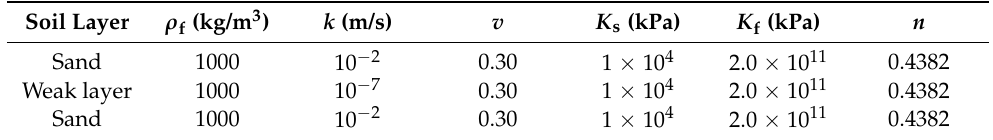
Table 3. Pore fluid parameters for DC analysis.